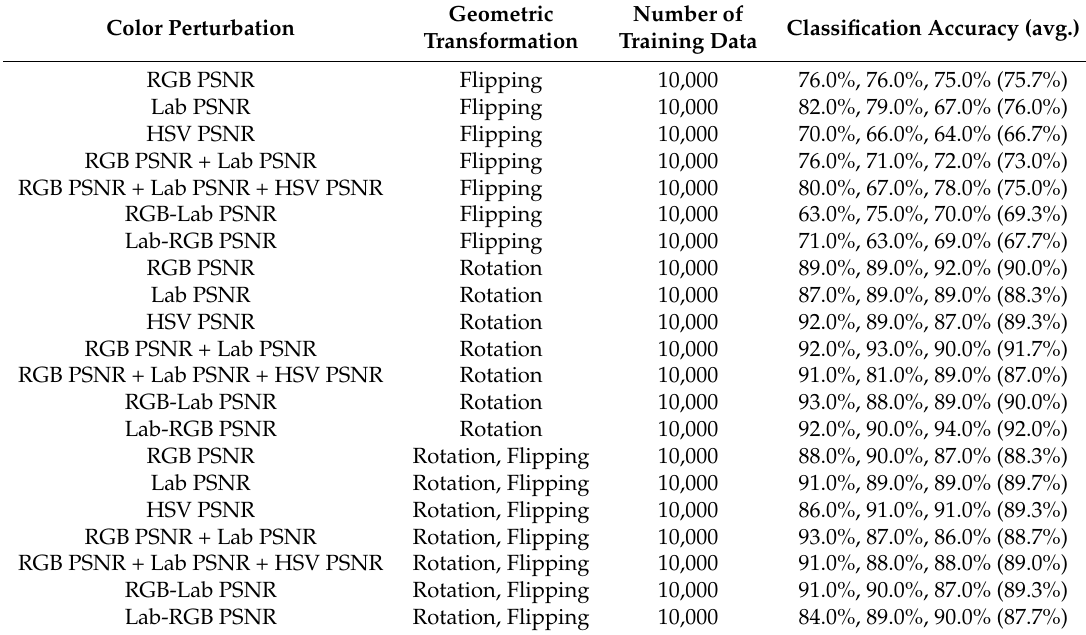
Table 8. Classification accuracy obtained upon applying the inverse PSNR method and two geometric transformations with an equal number of training